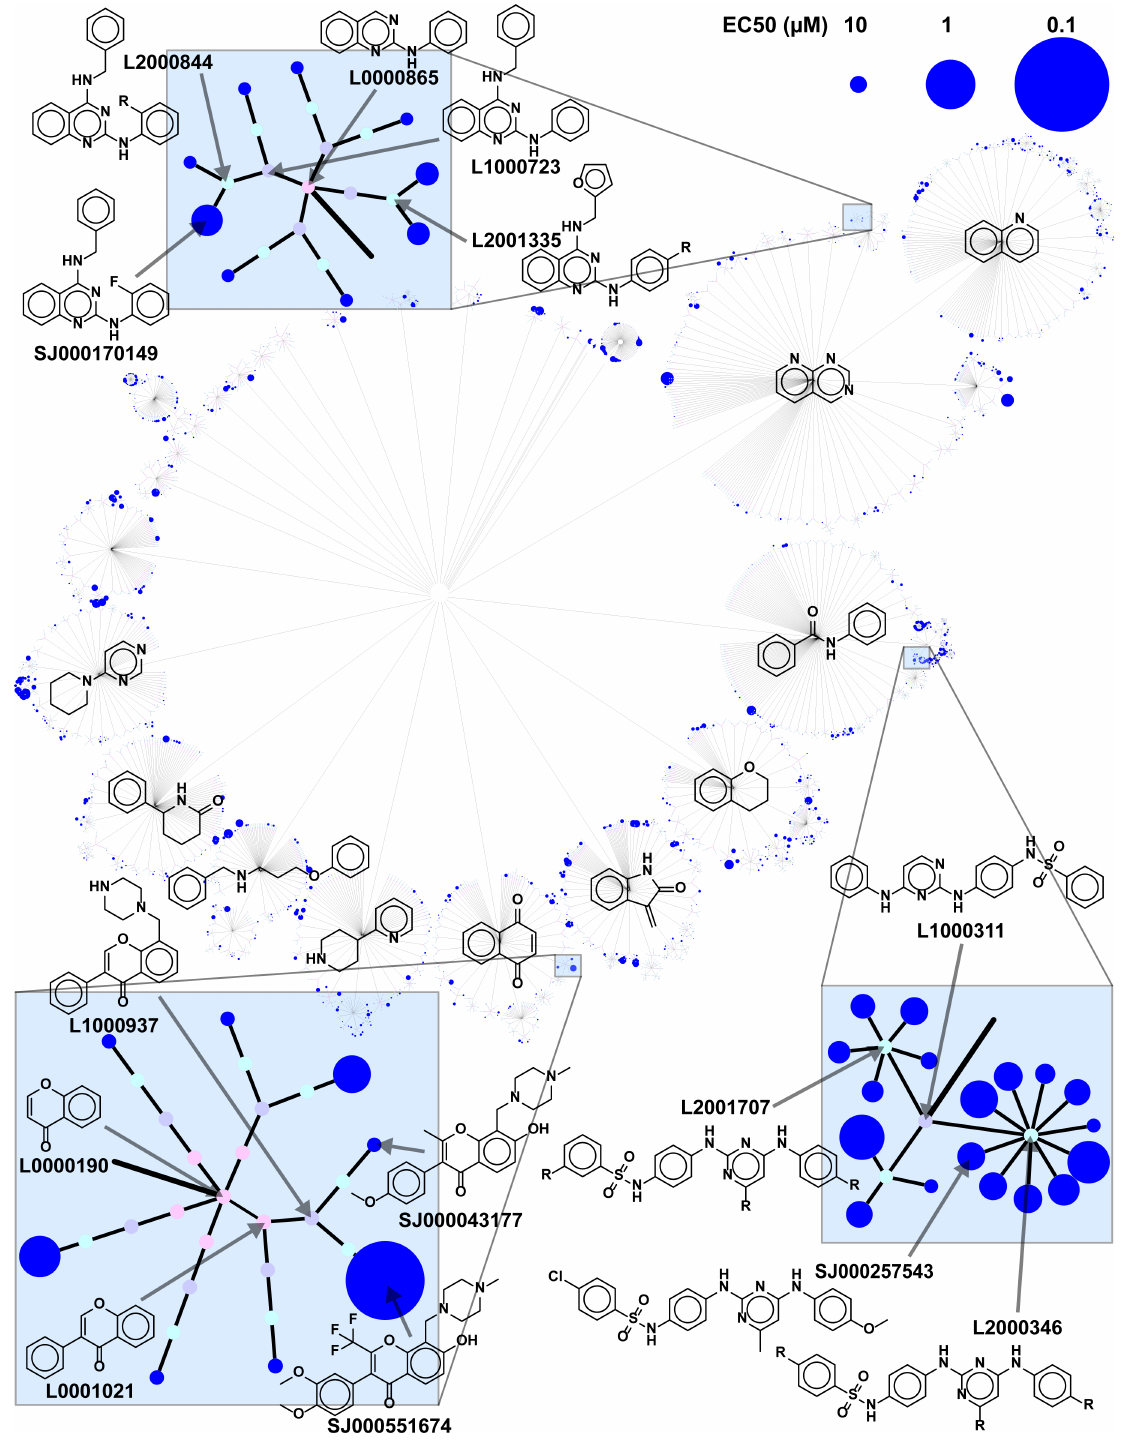
Fig 2. Identification and structure clustering of antileishmanials identified from the HTS campaign. Chemical structure network graph showingthe structural clusters and antileishmanial potenciesof the 2,703 primary screen hits. Topologically similar moleculescluster together in the branches of the network. The graph was constructed by first abstractingmoleculesto scaffolds and then to cores using the Murcko algorithm[35]. Each of these structural entities is representedas a node, and nodes are connectedvia edgesaccordingto topologicalrelationships, with closenessbeing definedusing the Tanimoto coefficient [57]. The colors of the nodes represent increasing functionalization of the scaffold core structures, starting from pink